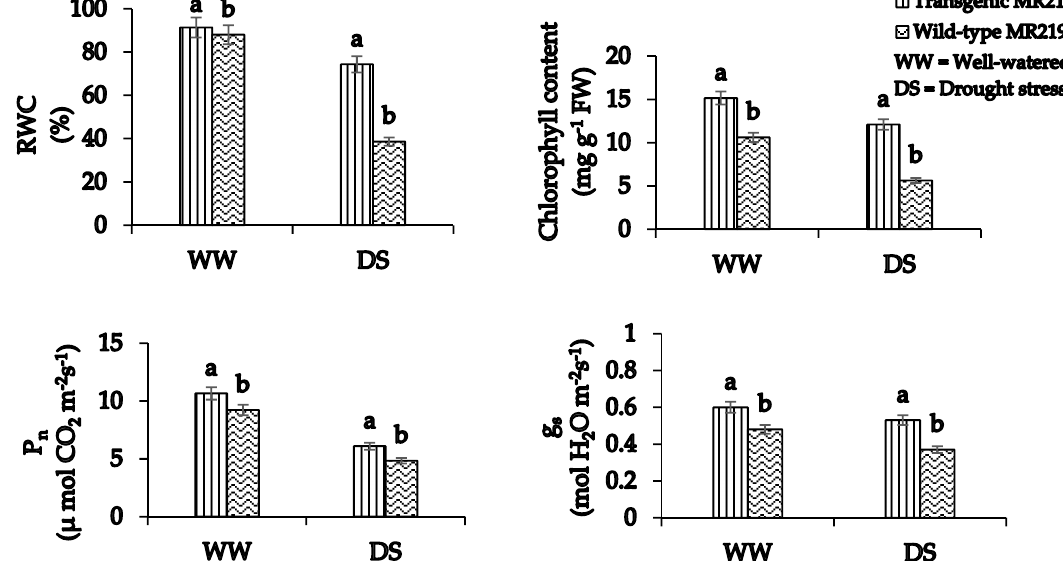
Figure 1. E ff ects of drought stress treatment on RWC, chlorophyll content, P n , and g s in rice genotypes. Vertical bars represent the standard error of the mean. Values within the drought stress treatment with the di ff erent letters (a and b) are significantly di ff erent based on comparison using DNMRT at p ≤ 0.05 ( n = 12).